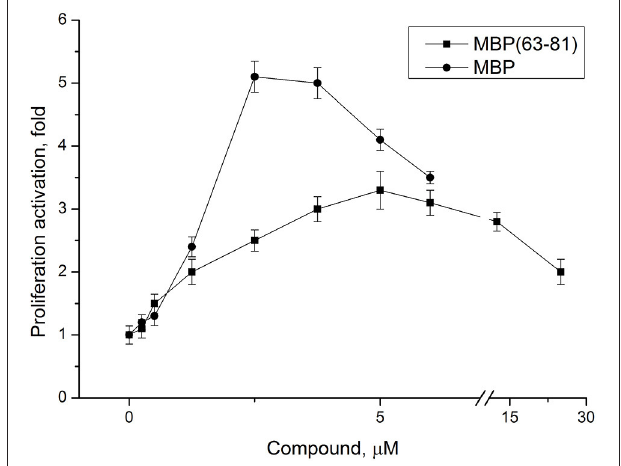
FIGURE 3 | Dose-dependent effect of MBP(63-81) and MBP on LN lymphocyte proliferation. LN lymphocytes were isolated from lymph nodes of EAE rats. Each value shown is the mean ± SEM ( n = 4). p < 0.05, by Friedman’s ANOVA.